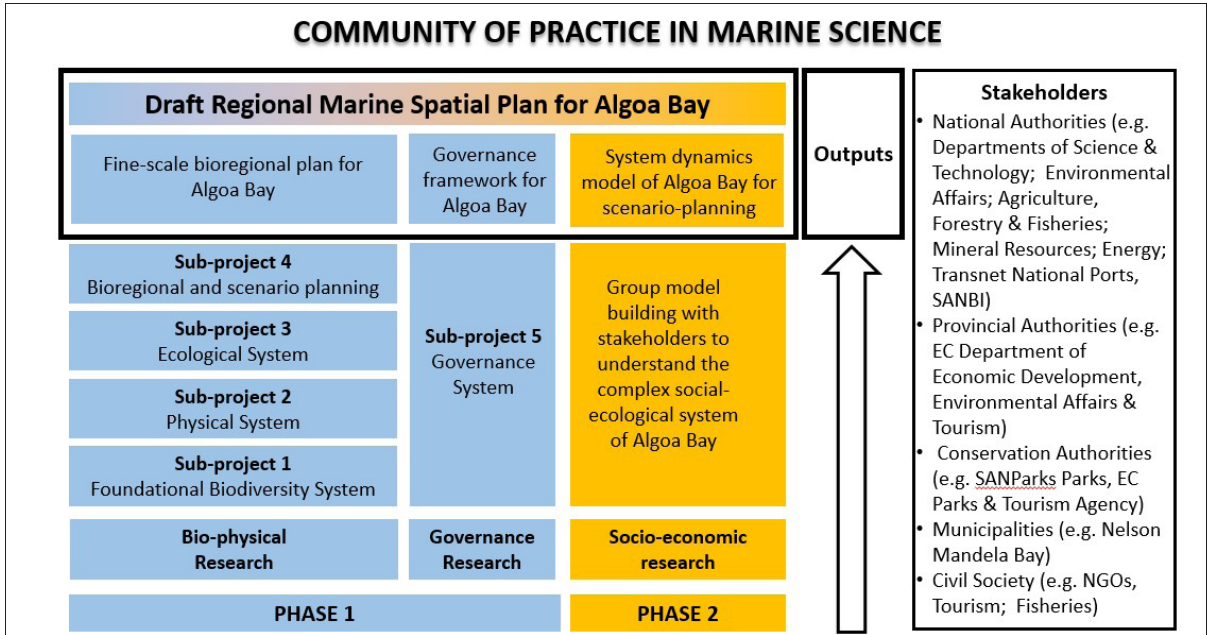
Figure 2: Research plan for the Algoa Bay